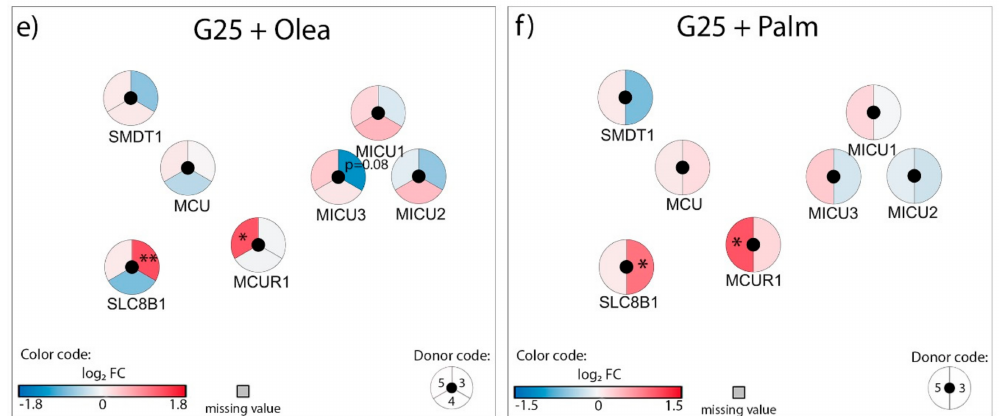
Figure 6. E ff ects of high 25 mM glucose (G25) and 0.4 mM oleate (Olea) or palmitate (Palm) on the transcriptional regulation of mitochondrial calcium transport genes. Human islets were exposed to ( a ) Olea at G5.5, ( b ) Palm at G5.5, ( c ) G25, ( d ) G25 + Olea + Palm, ( e ) G25 + Olea, and ( f ) G25 + Palm for 3 days before RNA-Seq analysis. E ff ects of culture conditions on transcript levels are compared to standard G5.5 medium and shown as upregulated (red), downregulated (blue), or unchanged (white). Missing values are represented in grey. Each disk is split into individual changes for the di ff erent donors. Color code reflects the transcriptional changes in log 2 fold changes (log 2 FC) for that particular gene in individual donors. * adjusted p < 0.05, ** adjusted p < 0.01 between control 5.5 mM glucose and the specific culture